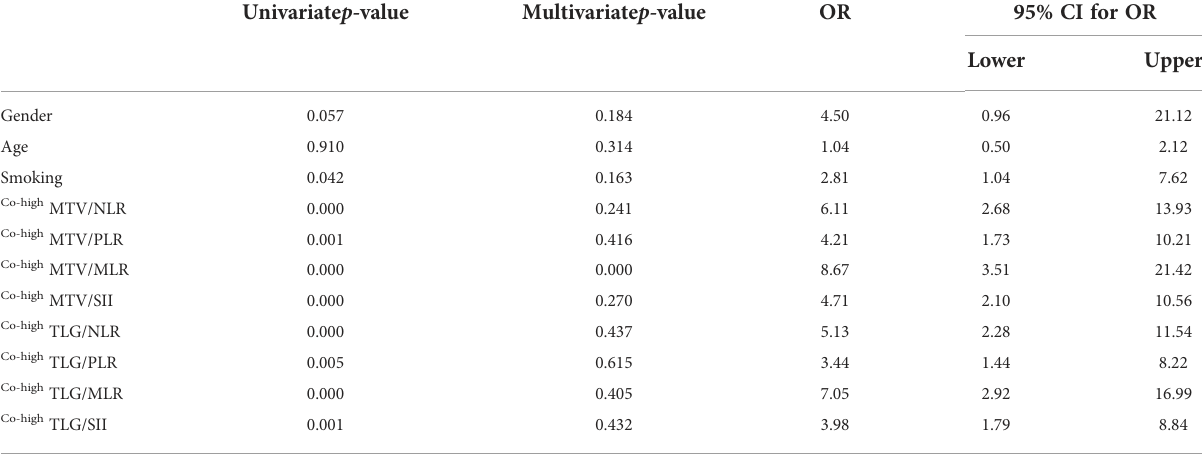
TABLE 6 Univariate and multivariate logistic regression analysis of potential relationships between patients ’ characteristics and binary stage of SCLC. Univariate p -value Multivariate p-